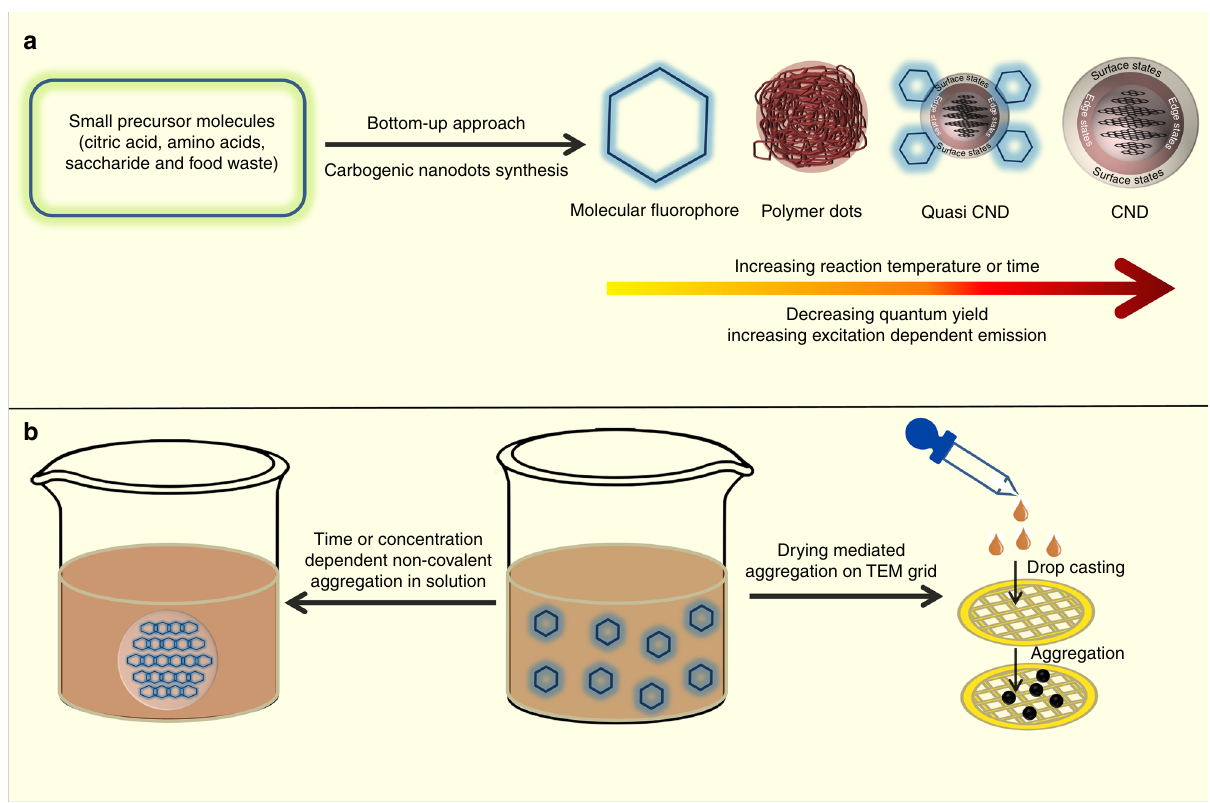
Fig. 1 Bottom-up synthesis of carbogenic nanodots (CNDs) from small molecular precursors. a Synthesis may produce a complex mixture of molecular fl uorophores, polymer dots, quasi CNDs, CNDs and b aggregated molecular fl uorophores. The aggregated structure may also form by drying mediated aggregation of the fl uorophore on the TEM